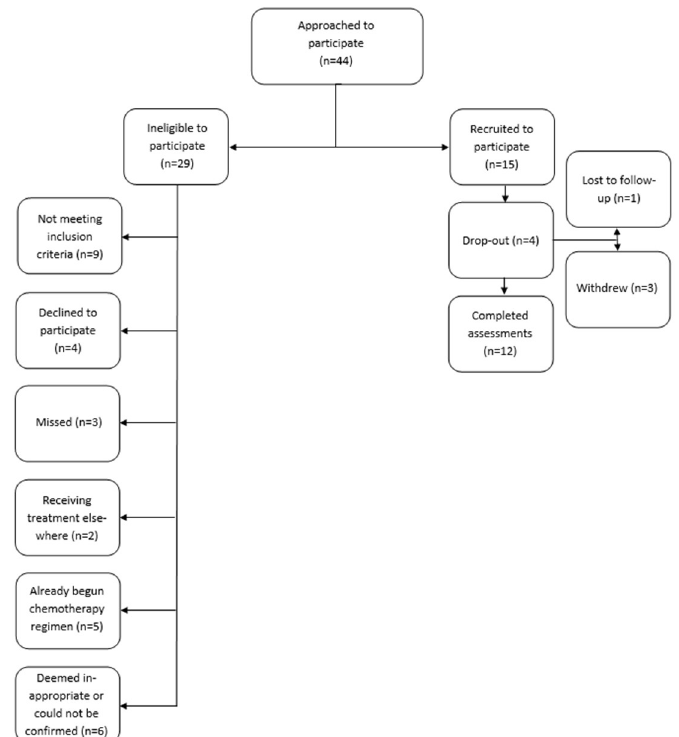
Figure 1. Flow Figure 1. Flow chart. Table 1. General characteristics of metastatic breast cancer patients undergoing chemotherapy.